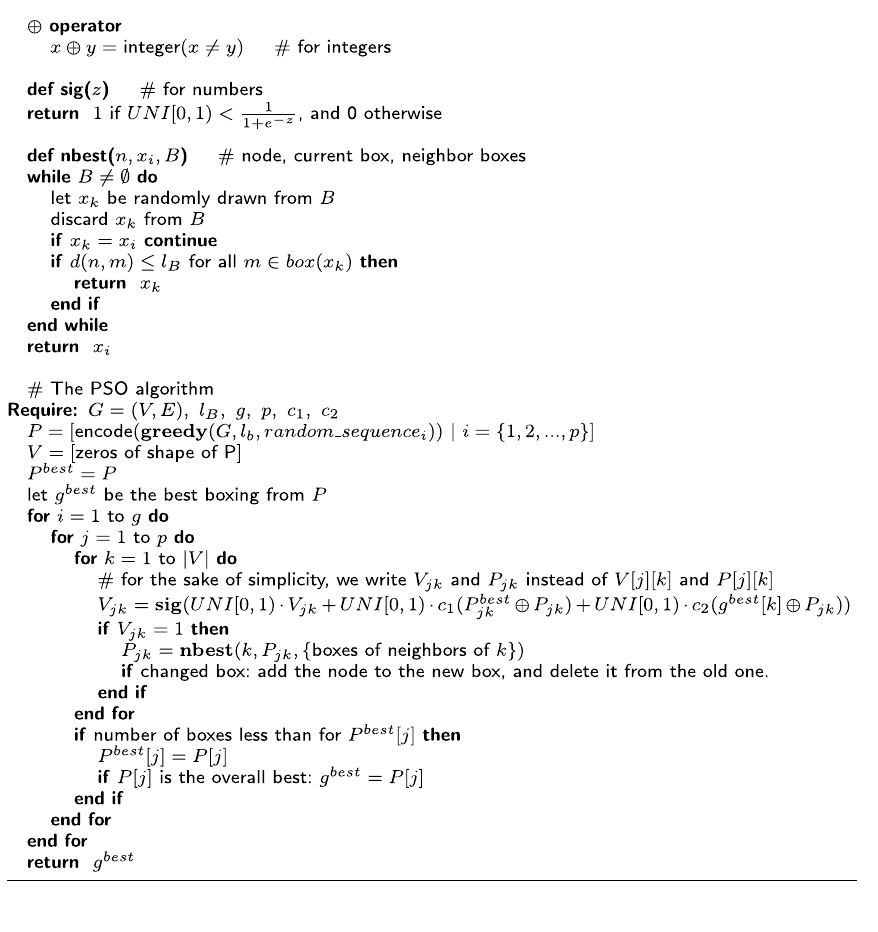
Fuzzy algorithm The fuzzy box-covering algorithm and the corresponding concept of fuzzy fractal dimension were introduced by Zhang et al. (2014). The authors propose a novel scheme for estimating the fractal dimension of a network. Instead of assigning boxes, they introduce a measure to estimate the fraction of the network one box covers on average. For each node, a box of radius r B around a central node is con- structed and the contributions of the nodes of the box are summed. This contri- bution is a so-called “membership function” that exponentially decays with the distance from the central node. After aggregating and normalizing these contribu- tions, we get an estimation of the proportion of the network that a box covers on average. Taking its inverse gives the approximating box